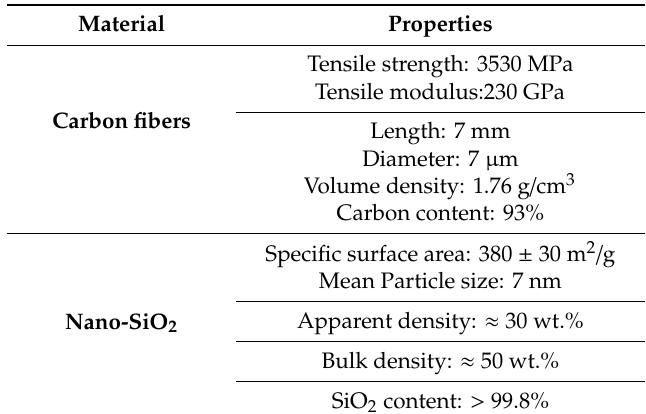
Table 1. Major properties of carbon fibers and nano-SiO 2 .